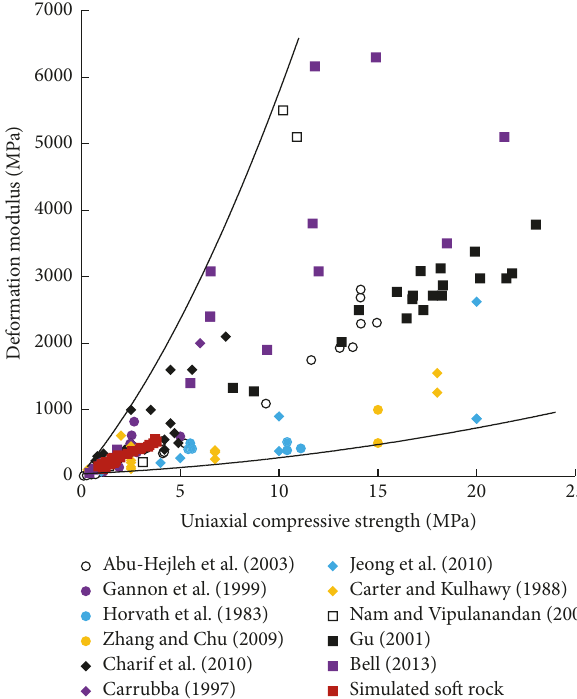
Figure 4: Relationship between the deformation modulus and uniaxial compressive strength of simulated soft rock in this study and previous studies (data from